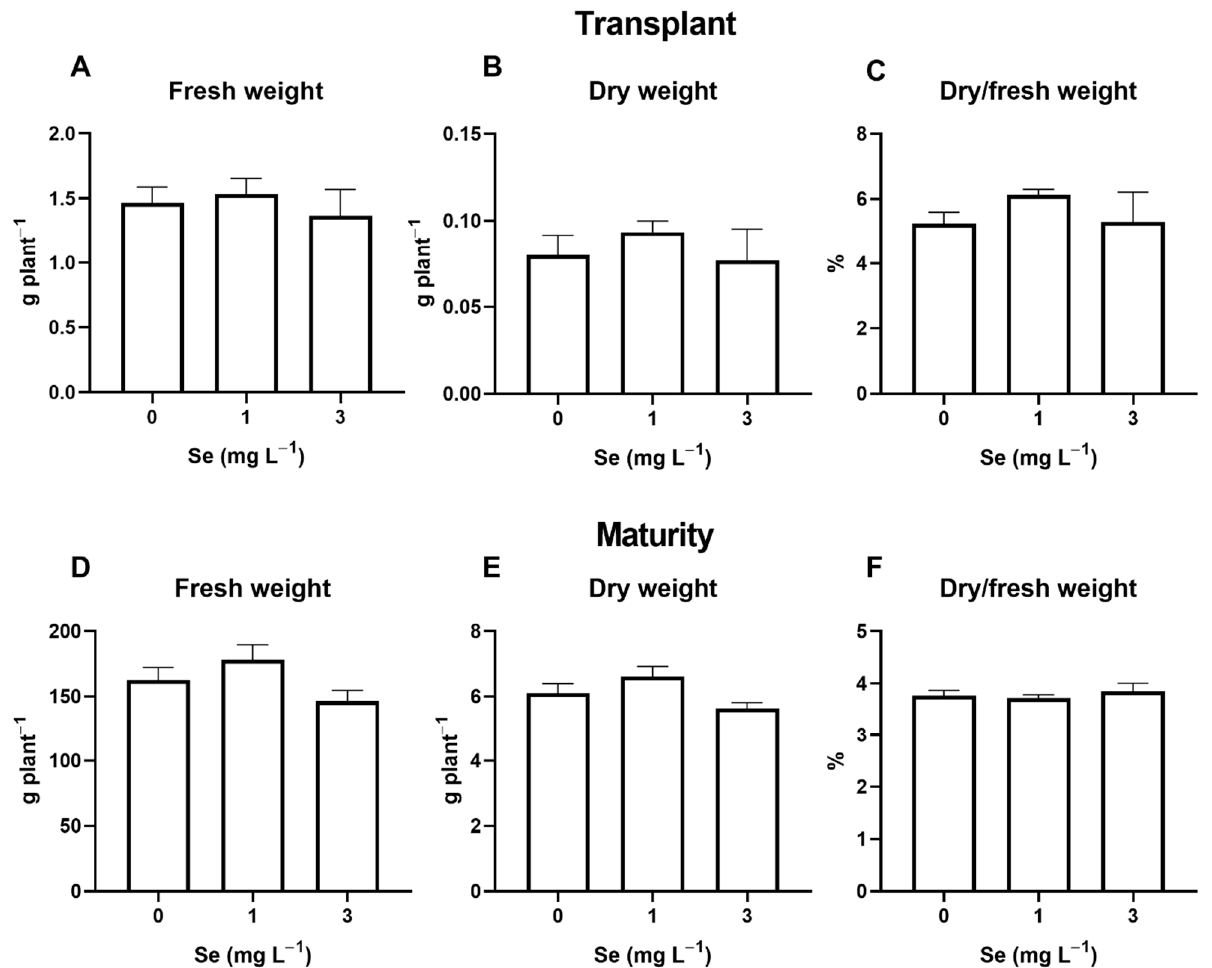
Figure 1. Fresh (FW) and dry (DW) weight, and dry matter percentage (DW/FW) of lettuce plants, measured at transplant ( A – C ) and maturity ( D – F ), treated with different concentrations of Se at pre-transplanting.